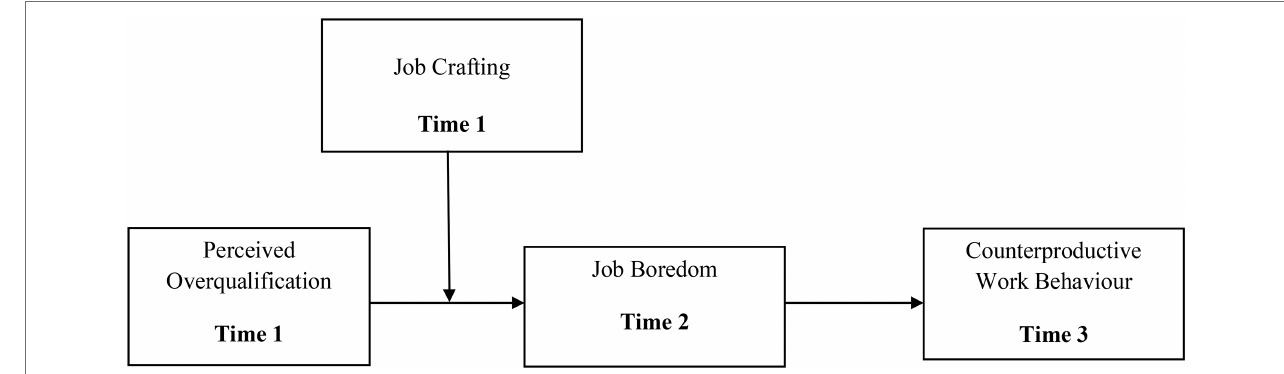
FIGURE 1 | Hypothesized moderated mediation